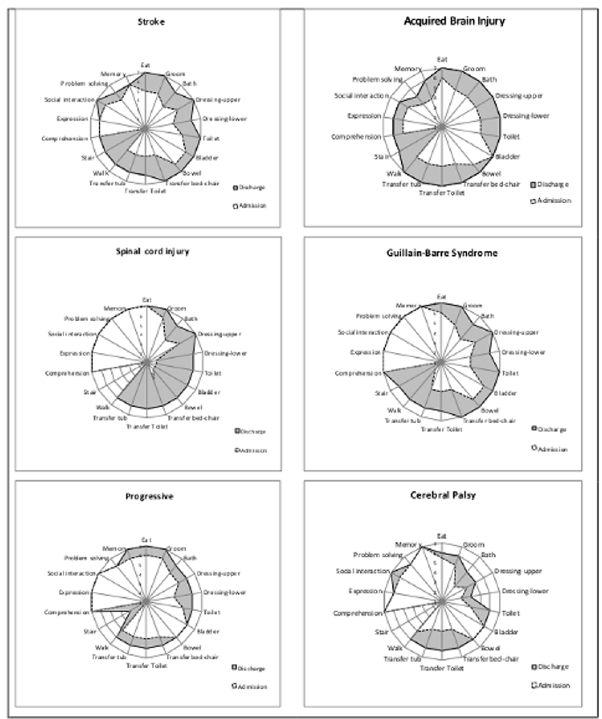
Fig 4. FIM — Splat Motor and Cognitive change score. The FIM-Splat provides graphic presentation of the disability profile in a radar chart. The 18 items are arranged as ‘ spokes of the wheel ’ and the Levels from 1 (total dependence) to 7 (total independence) run from the centre outwards. Thus a perfect score would be demonstrated as a large circle. The group median scores for each item are plotted for admission and discharge. The difference between median scores on admission and discharge is depicted by the shaded